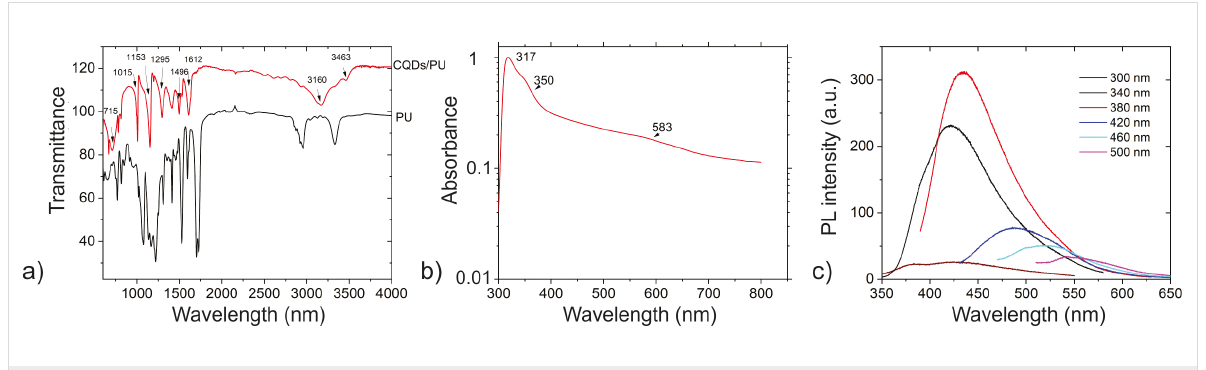
Figure 2: (a) FTIR spectra of PU and CQDs/PU; (b) UV–vis spectrum of CQDs/PU; (c) PL spectra of CQDs/PU.